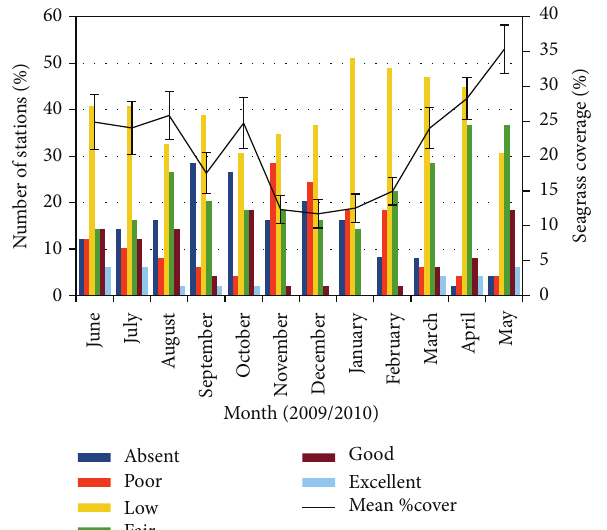
Figure 3: Monthly variations of grouped seagrass percentage cover and mean seagrass percentage cover (%) ± S.E from June 2009 to May 2010.